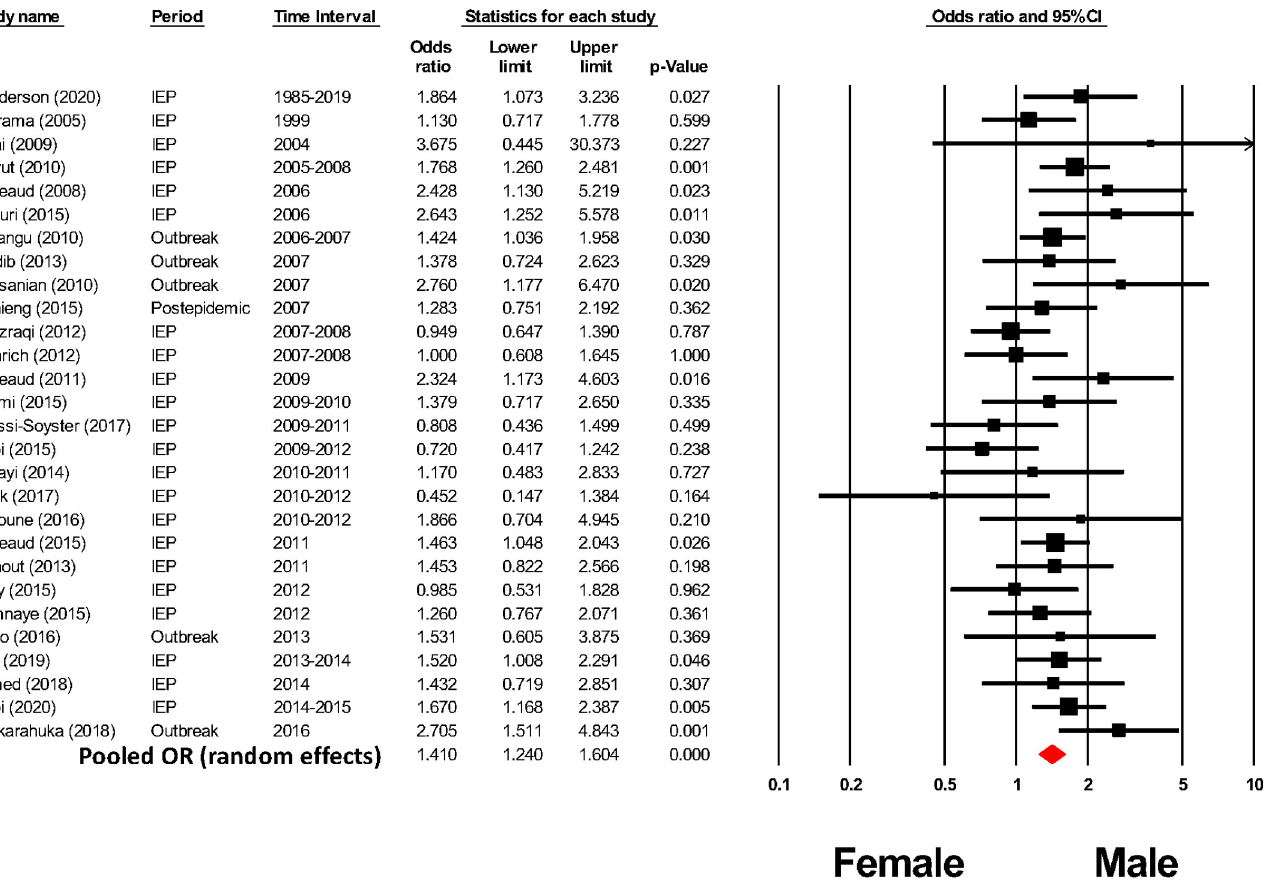
Fig 7. Meta-analysis of the impact of human gender on odds of RVFV exposure in at-risk populations.